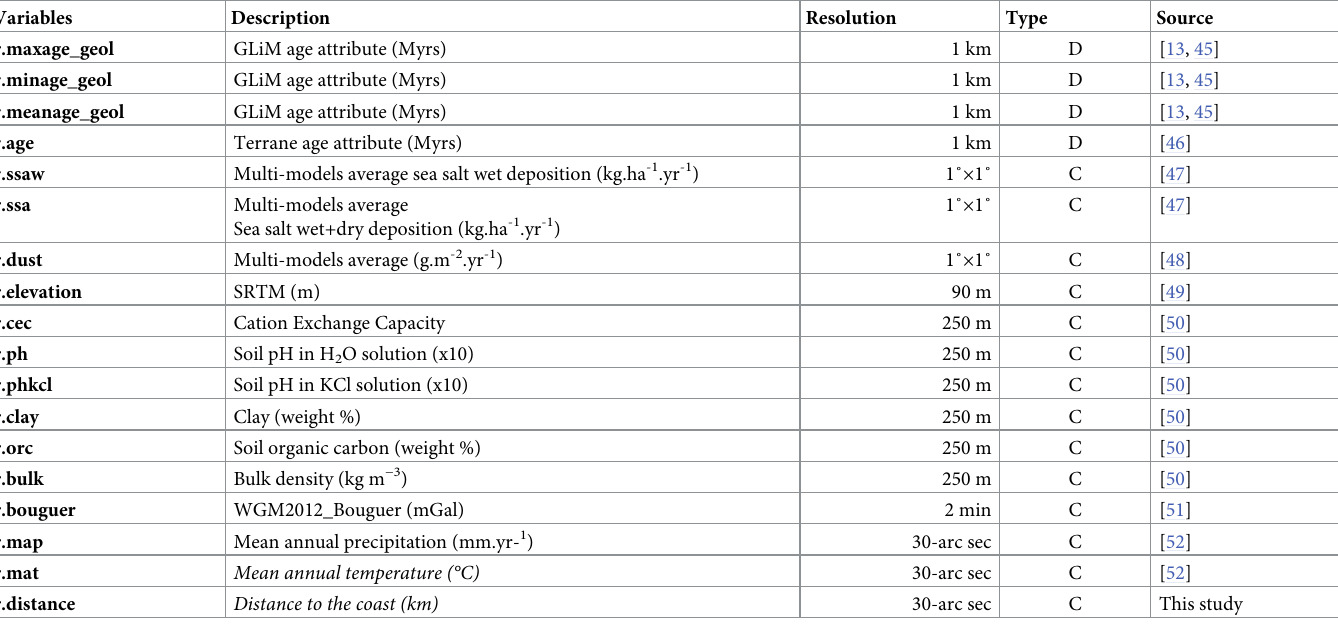
Table 1. List of geological, climatic, environmental and anthropogenic variables used in the multivariate regression.